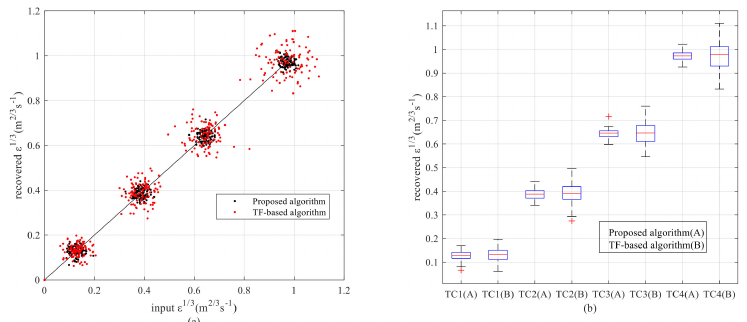
Figure 13. ( a ) input and recovered EDR value ( b ) statistics of two algorithms.